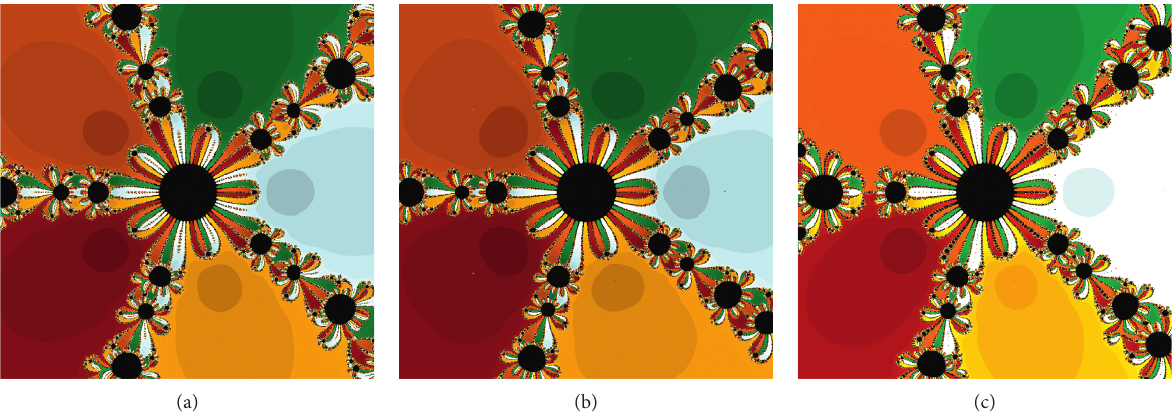
Figure 5: Basins of attraction associated with the polynomial p Algorithm 3.